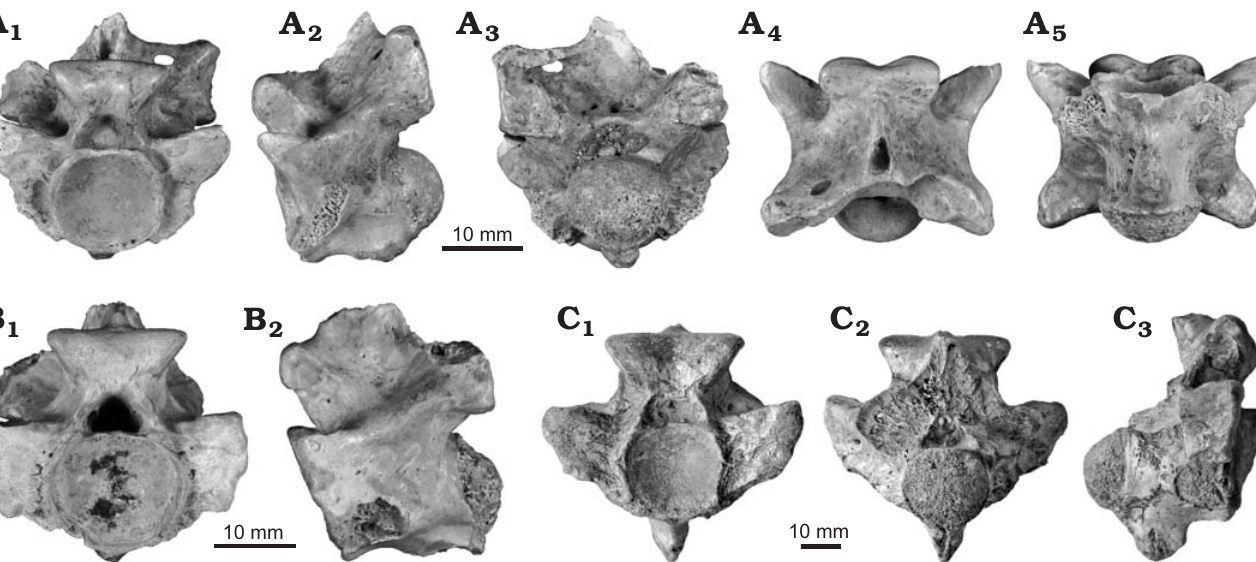
Fig. 4. Mid-trunk vertebrae of palaeophiid snake Palaeophis colossaeus Rage, 1983 from the Eocene of Tamaguélelt Formation, Mali. A . CNRST-SUNY 310; in anterior (A 1 ), lateral (A 2 ), posterior (A 3 ), dorsal (A 4 ), and ventral (A 5 ) views. B . CNRST-SUNY 325; in anterior (B 1 ) and lateral (B 2 , reversed to facilitate comparisons) views. C . CNRST-SUNY 290; in anterior (C 1 ), lateral (C 2 ), and ventral (C 3 )